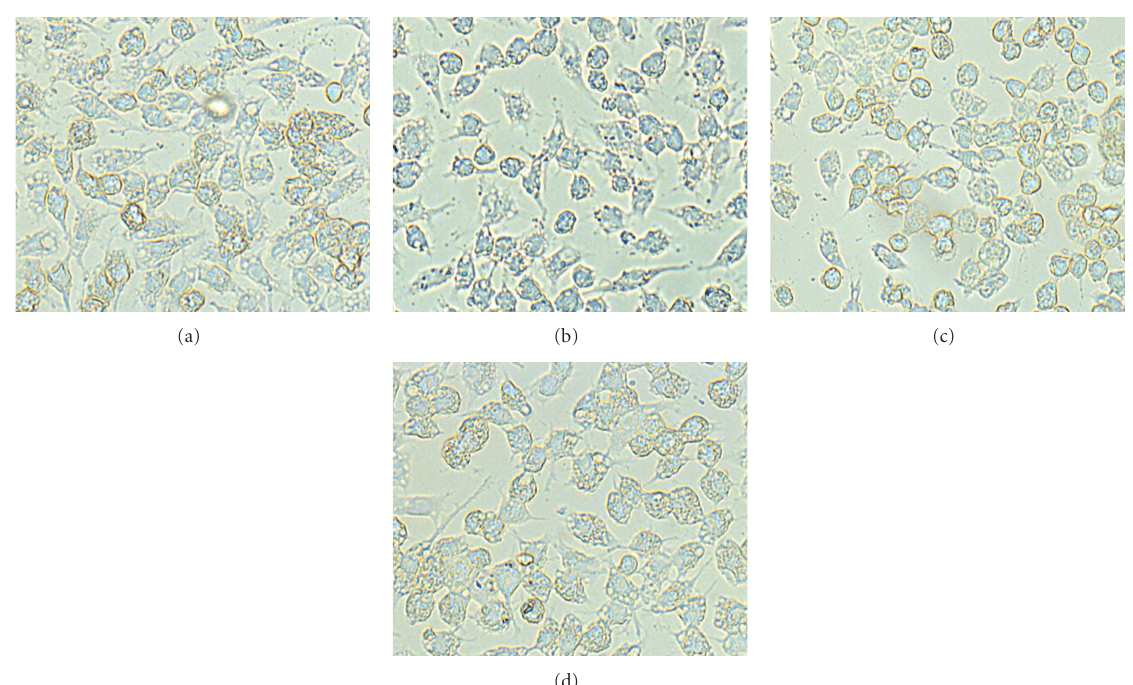
Figure 1: Morphology of RAW 264.7 cells cultured in standard medium (a), after stimulation with LPS (b), after LPS-stimulation and exposure to either total extract of Rhizoma coptidis (dilution 1 : 5) (c), or to berberine (10 − 4 mol) (d). Activation with LPS resulted in moderate reduction of total cell numbers and moderate altered cell morphology. No apparent morphologic changes were observed between the di ff erent LPS-stimulated